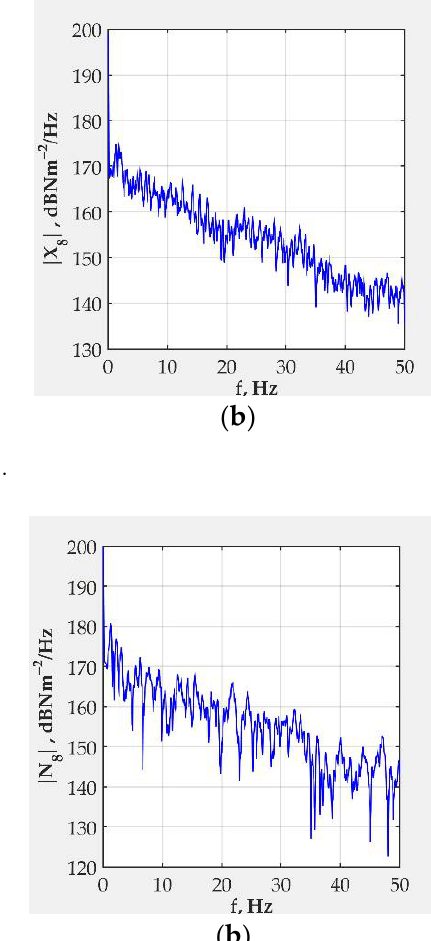
Figure 10. Magnitudes of output noise spectra: ( a ) The optimum linear frequency response functions, L i 7 , L i 8 , i = 1, 6, for the outputs locate system resonances and estimate system damping. The peak values of the optimal frequency response functions point to the natural frequencies of the system.